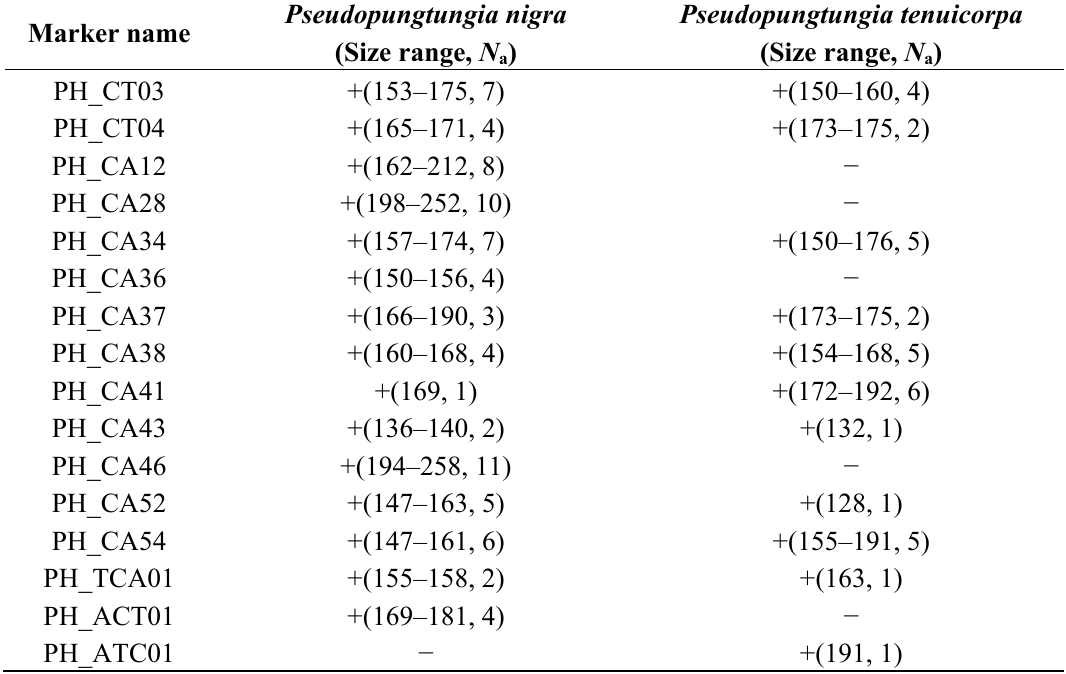
Table 3. Cross-species amplification of 16 microsatellite markers in Pseudopungtungia nigra ( n = 6) and Pseudopungtungia tenuicorpa ( n =